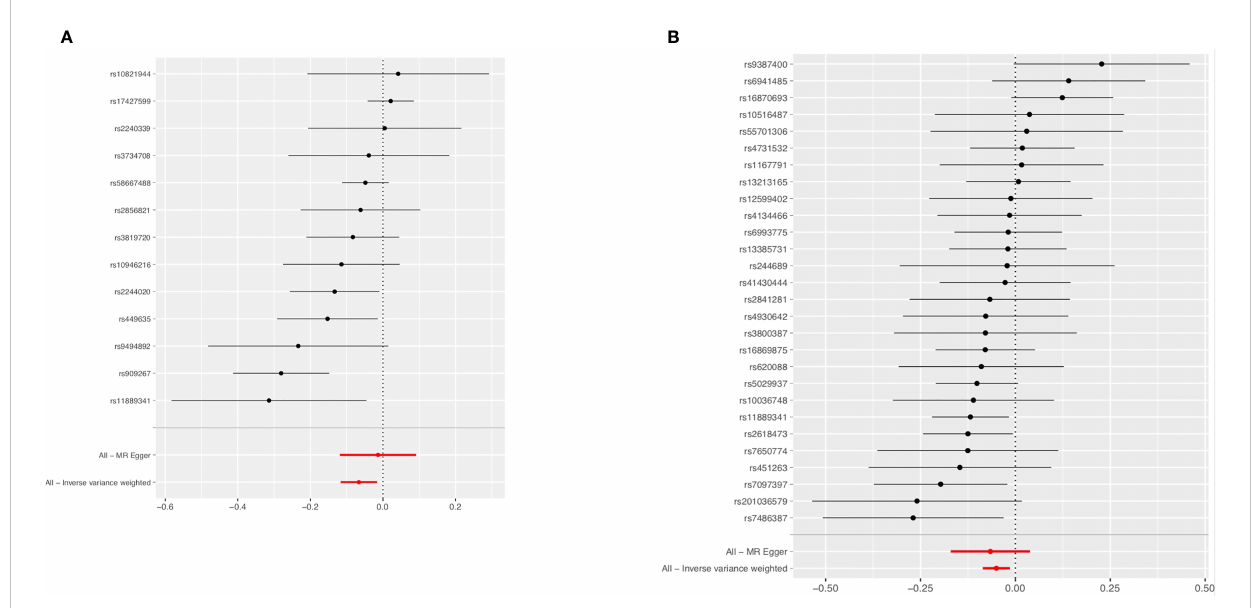
FIGURE 6 Forest plot of the effects of RA (A) and SLE (B) on BC in the East Asian population. BC, breast cancer; RA, rheumatoid arthritis; SLE, systemic lupus